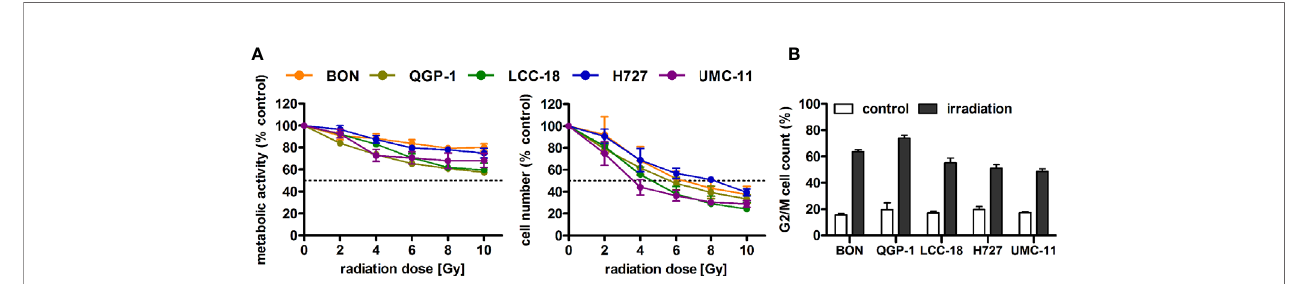
FIGURE 5 | Irradiation leads to reduced cell viability and G2/M accumulation of NEN cells. (A) NEN cell lines were irradiated with doses of 0 to 10 Gy, incubated for 96 h and analyzed for metabolic activity and cell number. Data represent mean ± S.E.M. (n=2 – 3). (B) NEN cell lines were irradiated with 10 Gy and samples were collected after 24 h for cell cycle analysis by fl ow cytometry. Data are shown as mean ± S.E.M. (n=2 – 3).